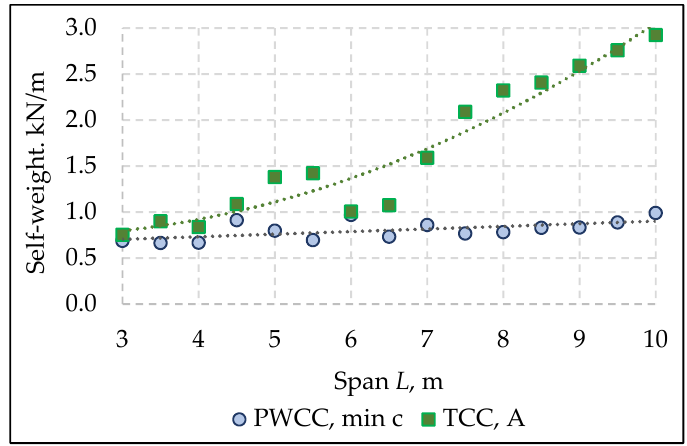
Figure 13. Self-weight of 1 m wide strip dependence of the panel span for CLT–concrete (CLTCC) and plywood–concrete (PWCC) panel in category A1 buildings, where min c —panel with the most cost-effective cross-section, and A—multi-storey residential building.